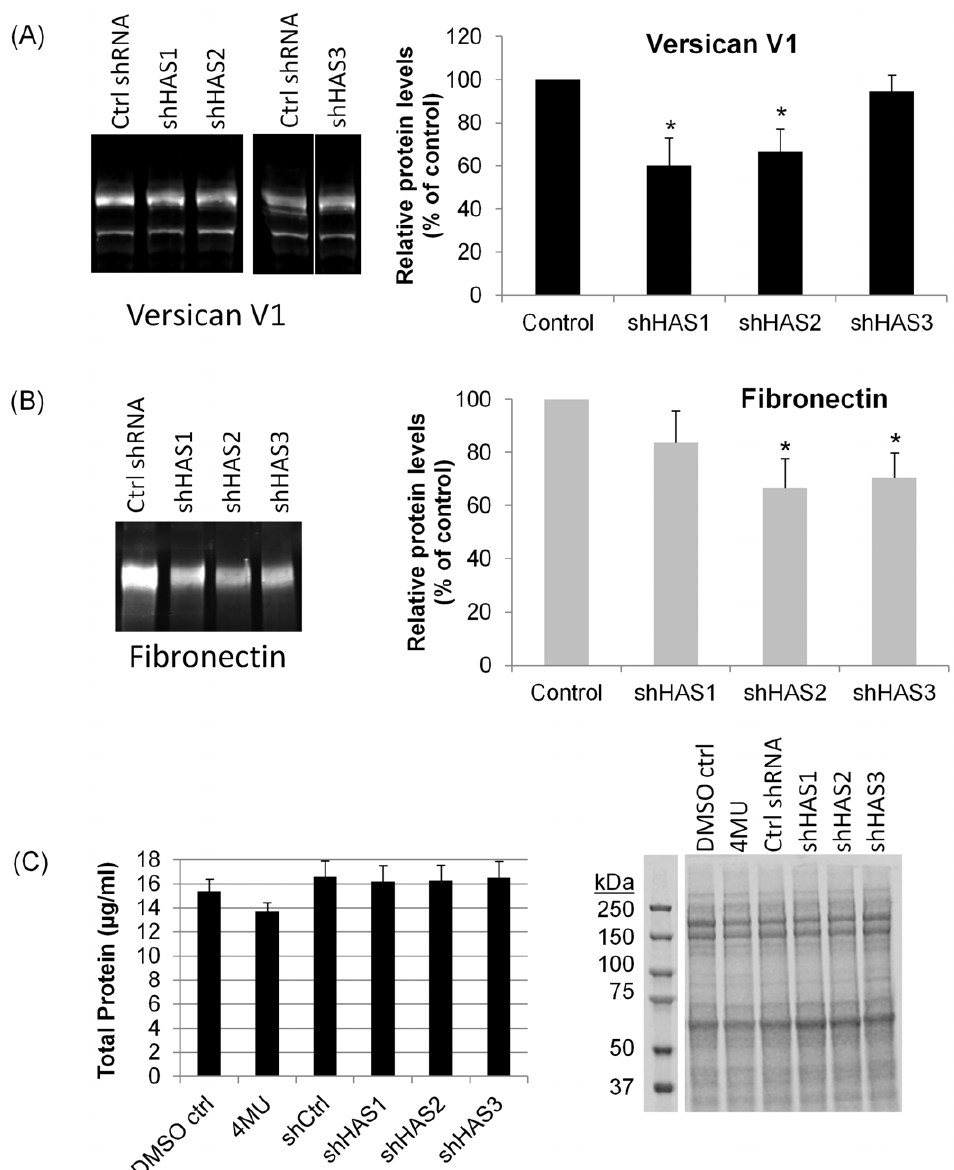
Figure 3. Versican and fibronectin protein levels in response to HAS gene silencing. TM cells were infected with shHAS silencing lentivirus targeting individual HAS genes. Versican and fibronectin protein levels in conditioned serum-free media were assessed by Western immunoblot on 7.5% (versican) or 5% (fibronectin) SDS-PAGE gels. (A) Versican V1 in shHAS-infected TM cells. Images originate from two separate experiments: ctrl shRNA, shHAS1 and shHAS2 were from adjacent lanes on one immunoblot, while ctrl shRNA and shHAS3 were from non-adjacent lanes of a second immunoblot. Densitometry of the versican V1 isoform showed a significant reduction in protein levels following shHAS1 and shHAS2 lentivirus infection (n=4). (B) Fibronectin in shHAS-infected TM cells. Densitometry of fibronectin showed a significant reduction in protein levels following shHAS2 and shHAS3 lentivirus infection (n=3). The fibronectin immunoblot shows adjacent lanes from a single blot. Versican and fibronectin values were normalized to total protein loaded and are presented as a percentage of the control. Error bars are the s.e.m. * P , 0.04 by one-way ANOVA. (C) Total protein (RIPA + media) was quantitated using the BCA assay for vehicle control (n=7), 4MU-treated (4 day treatment; n=7), shControl (n=6) and shHAS silenced TM cells (n=6). No significant differences were observed by ANOVA. A representative Coomassie-stained gel (7.5%) shows approximately equal loading of lanes for all treatments.